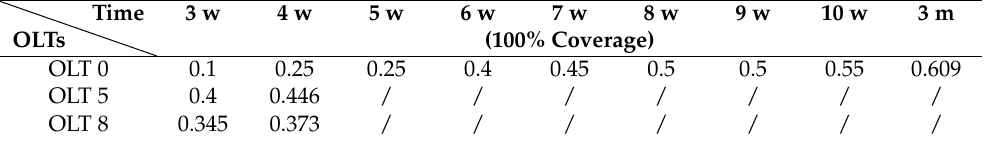
Table 7. Accuracy on different OLTs of different collection